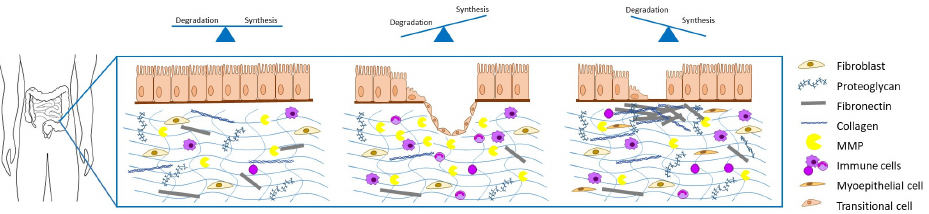
homeostasis ( left ), fistulizing disease ( middle ) and stricturing disease ( right